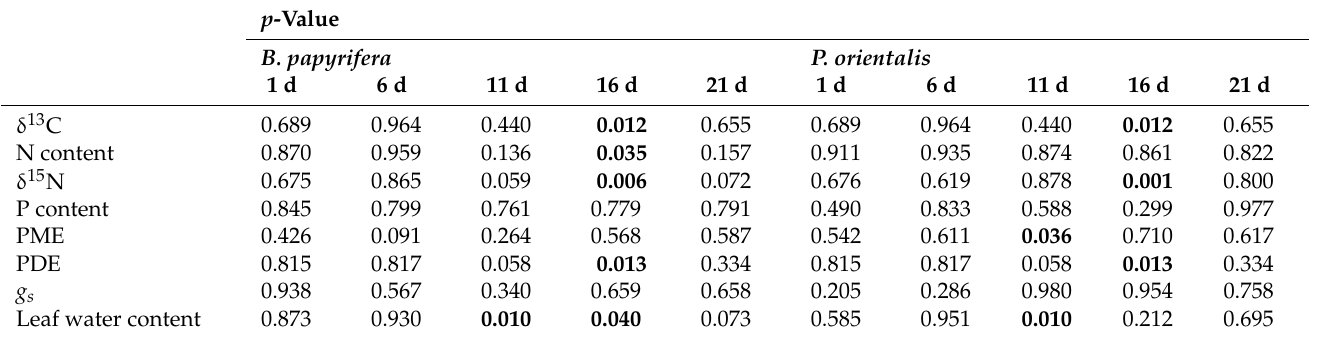
Table 2. p -values in solo planting and mixed planting conditions in B. papyrifera and P. orientalis